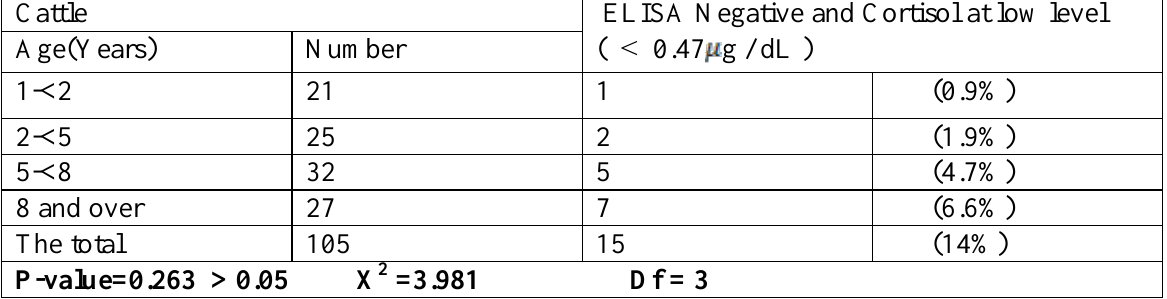
Table (8): The sixth group ELISA Negative and cortisol at low level Cattle ELISA Negative and Cortisol at low